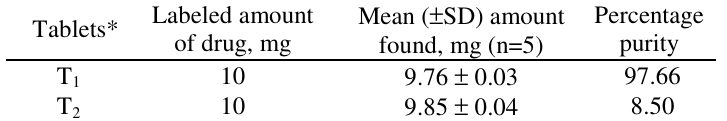
Table 4. Mean ( ± s.d.) amount of adefovir dipivoxil in tablet dosage forms by proposed RP- HPLC